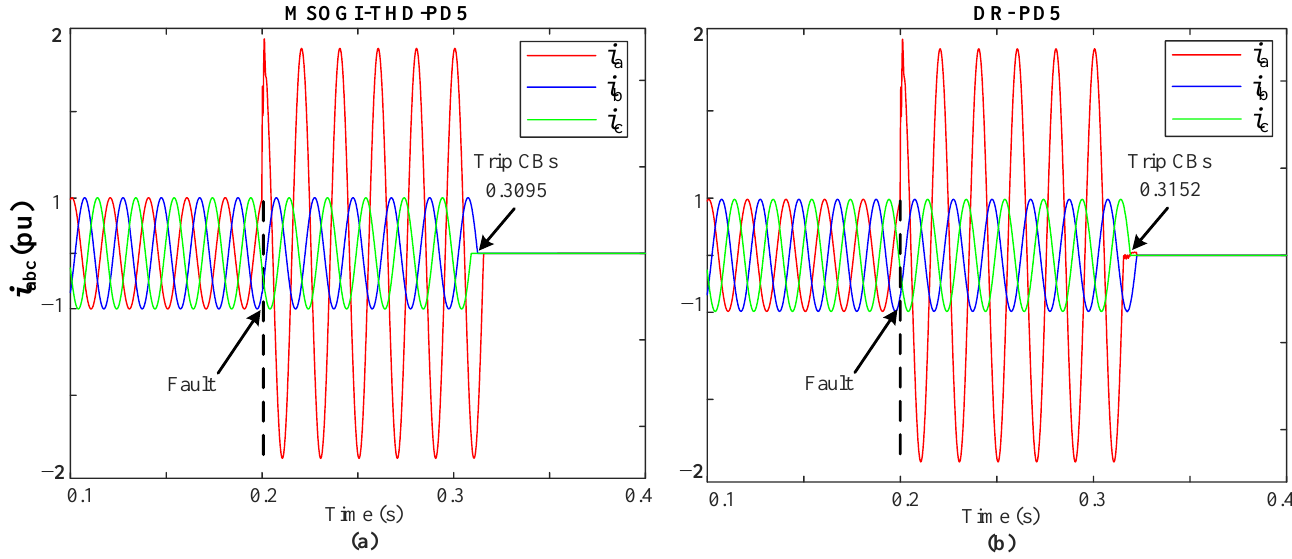
Figure 14. 𝑖 𝑎𝑏𝑐 currents during a 1PH-G (AG) fault at L3 using: ( a ) MSOGI-THD, ( b ) DR protection methods.